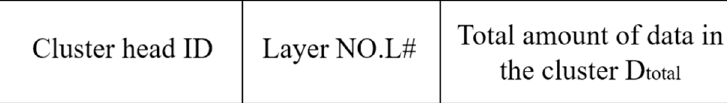
Figure 3. RTS (Request To Send) packet format of cluster member node (CM).